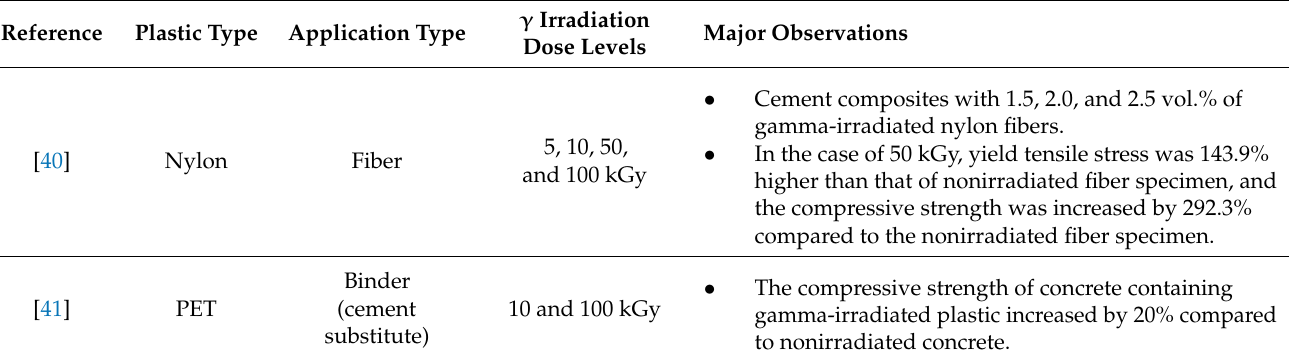
Table 2. Literature studies related to properties of cementitious composites that contain gamma-irradiated plastics.